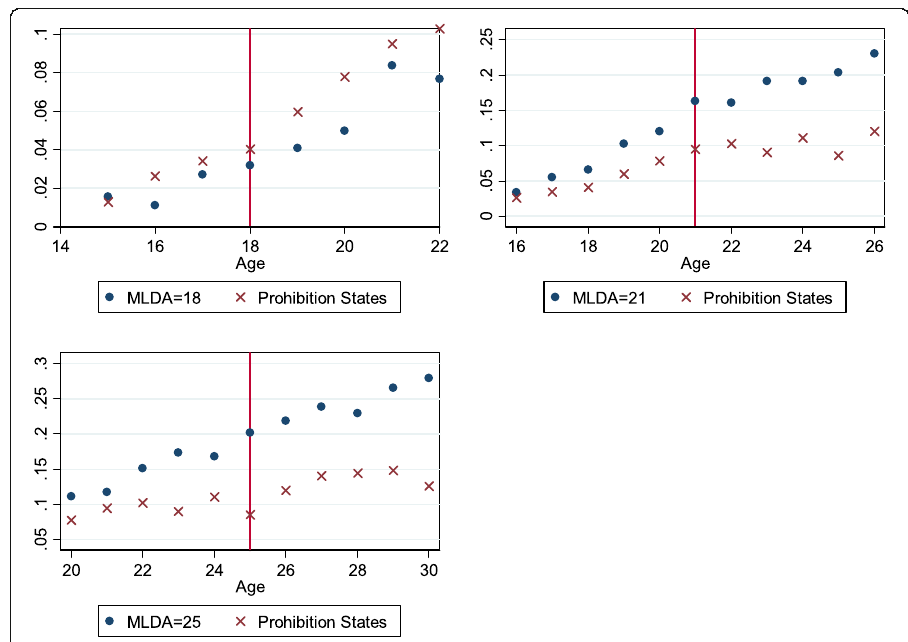
Fig. 2 Fraction of all men who drink, relative to their age in relation to the state ’ s MLDA and same-age